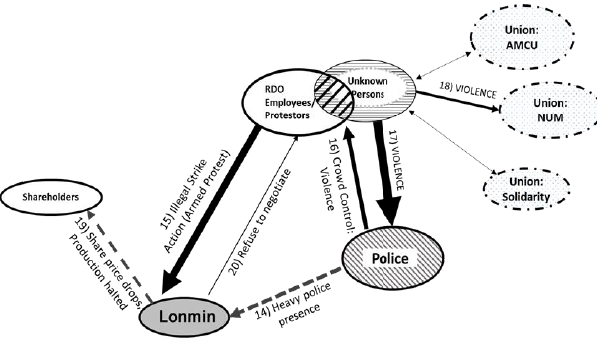
Figure 5: Stakeholder model for Lonmin (Period 11 to 15 August: Part 2)